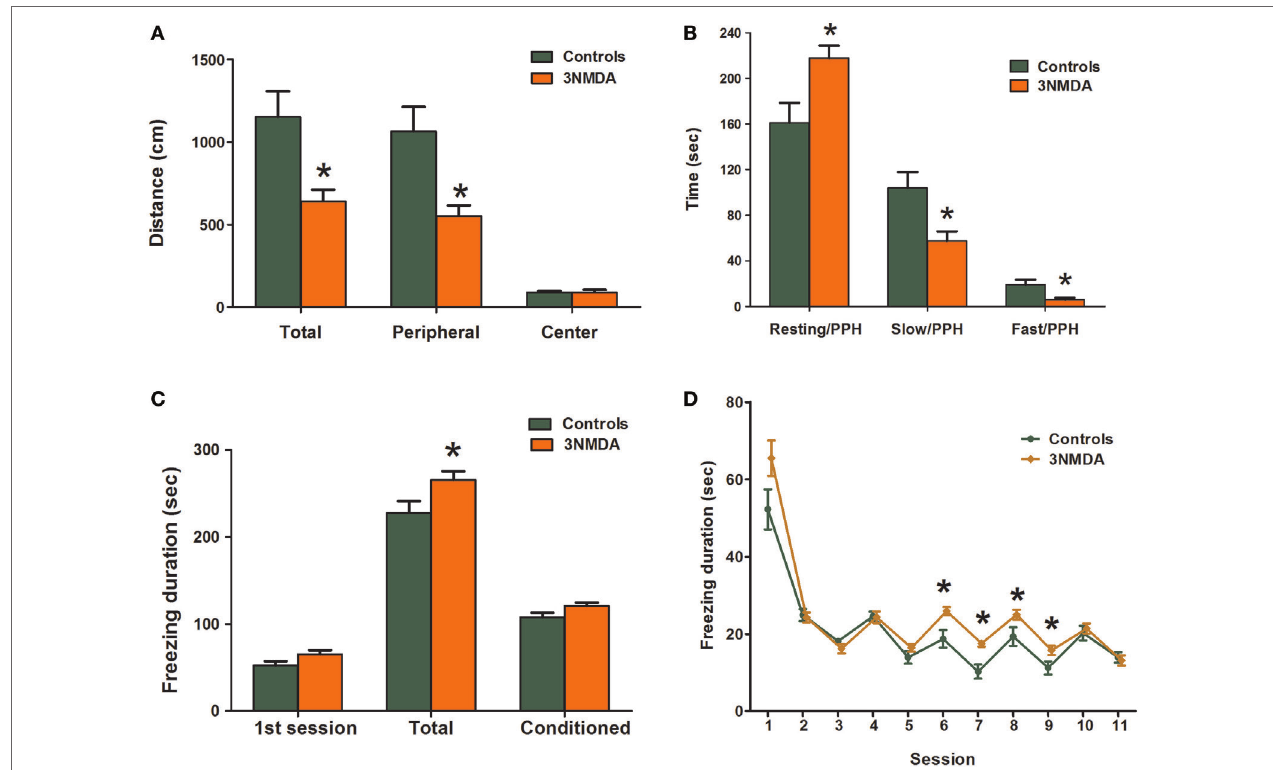
Figure 5 | Comparison of behavioral changes between rats with N -methyl- d -aspartate (NMDA)-induced spasms and controls. (a,B) Open-field test showing significantly decreased exploration distances in rats with NMDA-induced spasms in peripheral and total areas (a) and significantly increased resting activities and decreased slow and fast activities in the peripheral area (B) of rats with spasms. The rats with NMDA-induced spasms also showed significantly increased durations of freezing to sound and light stimuli (c) that persisted after several sessions without shocks (D) in a fear conditioning test. There was a significant difference in freezing durations between the two groups. *indicates a significant difference between the groups (* p < 0.05, Mann–Whitney U